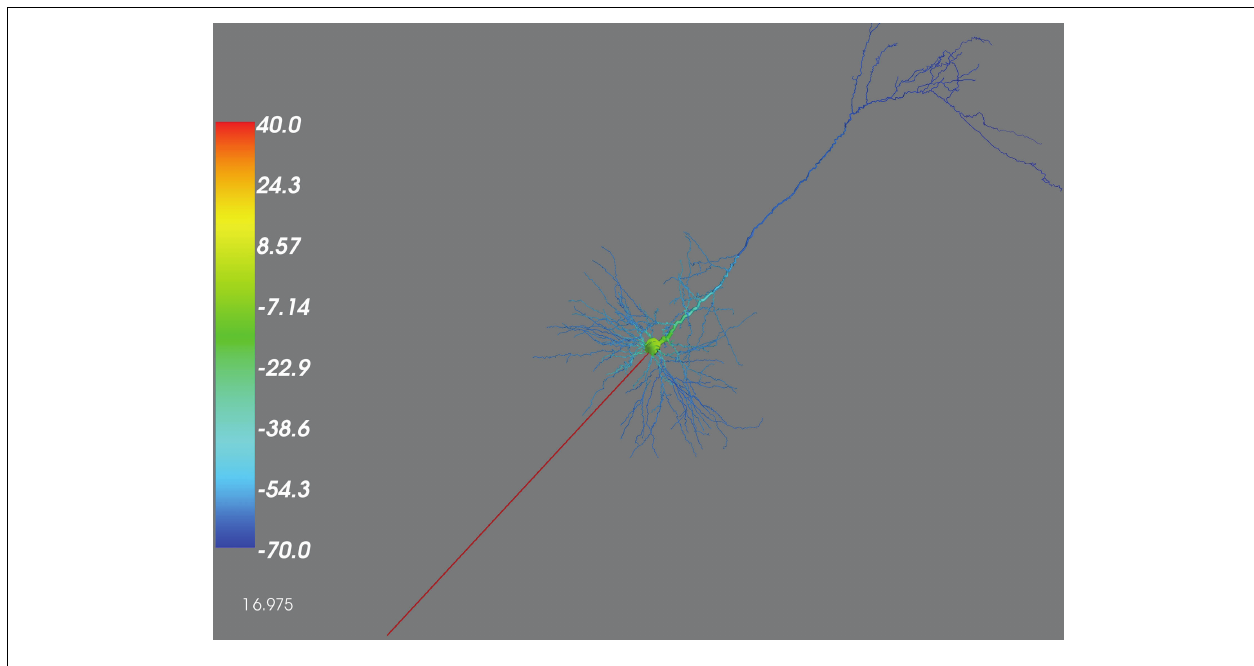
soma (yellow at + 20mV), and transmitted toward the dendrites (blue at − 70mv).The left color scale ranges from − 70mV (blue) through to + 40mV